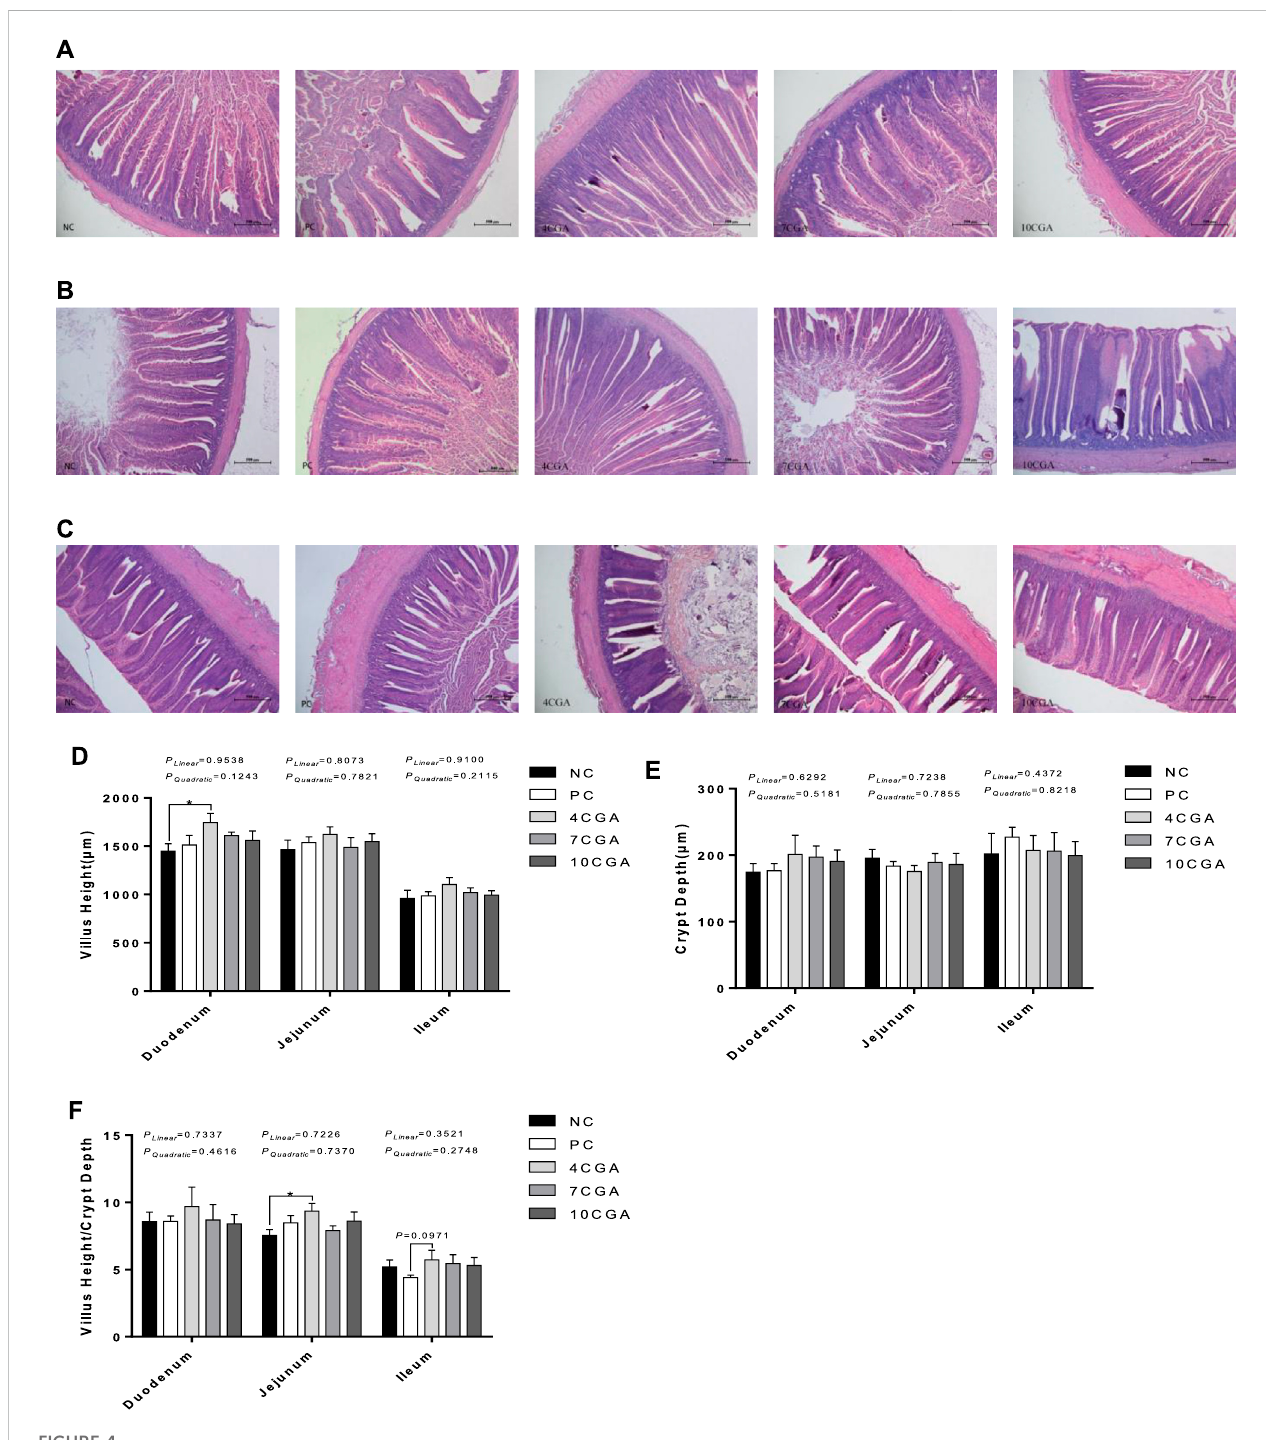
FIGURE 4 Effects of in ovo feeding of chlorogenic acid on intestinal morphology of 42 d-heat stressed broilers. (A) Duodenum; (B) Jejunum; (C) Ileum; (D) Villus Height; (E) Crypt Depth; (F) Villus Height/Crypt Depth. * indicates a signi fi cant difference between treatments ( p < 0.05), n = 6.